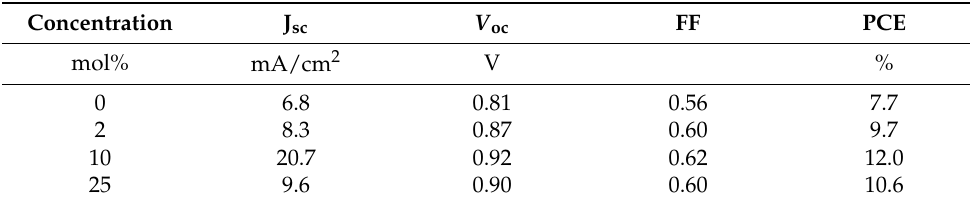
Figure 3. PL ( a ) spectra, ( b ) intensity, and ( c ) intensity ratio (‘efficiency’) of CH 3 NH 3 Pb(Cl,I) 3 with different Cl concentra- tions on FTO/TiO 2 .